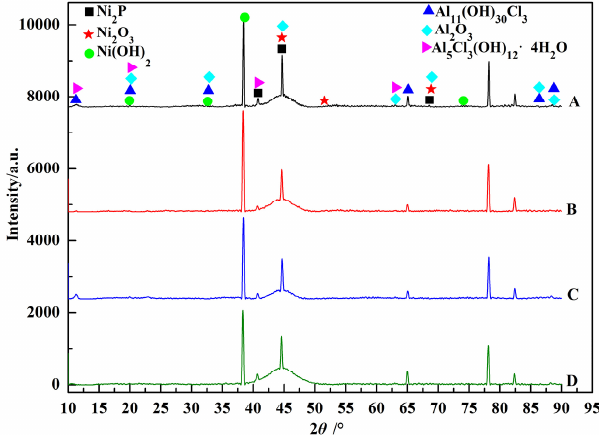
Figure 5. XRD patterns of the samples after electrochemical tests.